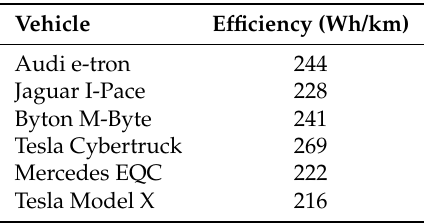
Table 5. Representative examples of the efficiency of real world vehicles collected from Reference [44].